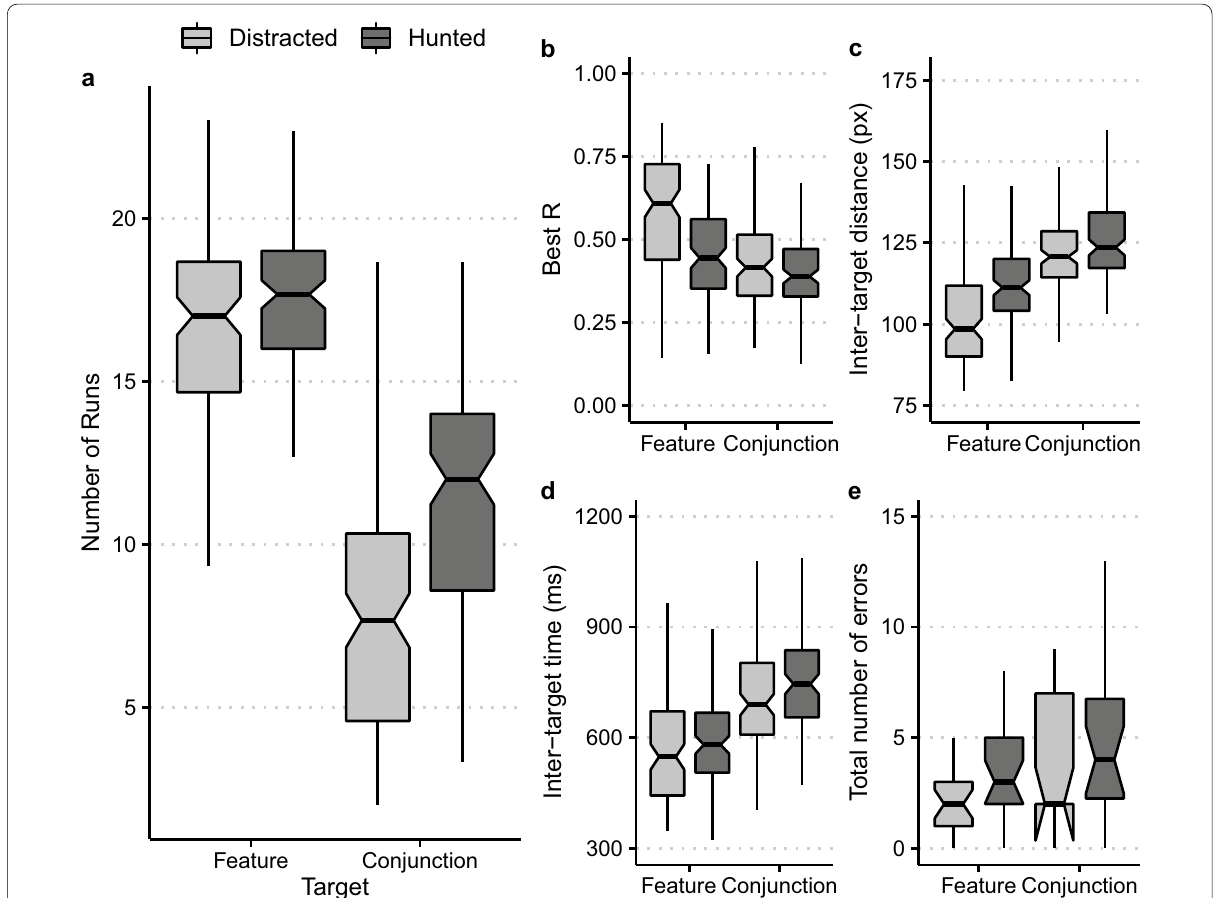
Fig. 2 The interaction between Predation (Distracted/Hunted) and Target (Feature/Conjunction) in Experiment 1. Horizontal lines show the central tendency (median) of each distribution, with notches indicating 95% confindence intervals. Boxes identify the upper (75%) and lower (25%) quartiles, with the whiskers indicating maximum and minimum